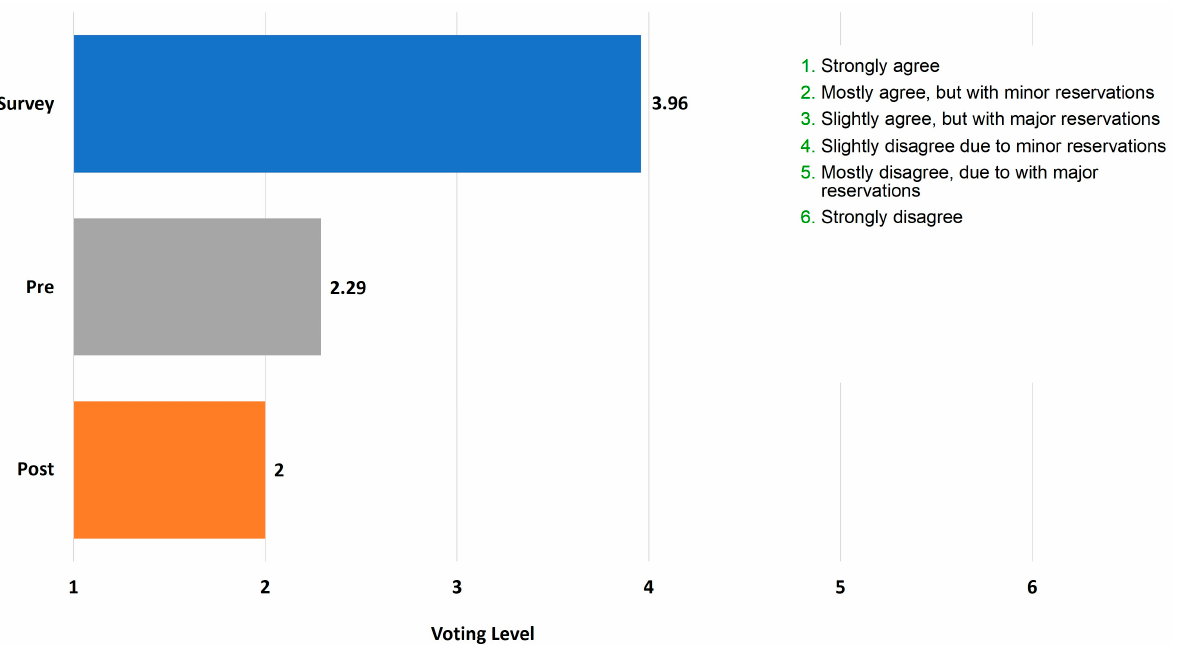
Figure 2. Mean voting level for the statement “ Trazodone should never be used as a first-line medication for insomnia ”. The blue bar represents the field survey respondents ( n = 508). The grey bar represents the panel members ( n = 7) before the clinical appraisal. The orange bar represents panel members ( n = 7) after the clinical appraisal meeting. The grading on the x -axis corresponds to the level of support, where 1 = strongly agree to 6 = strongly disagree.